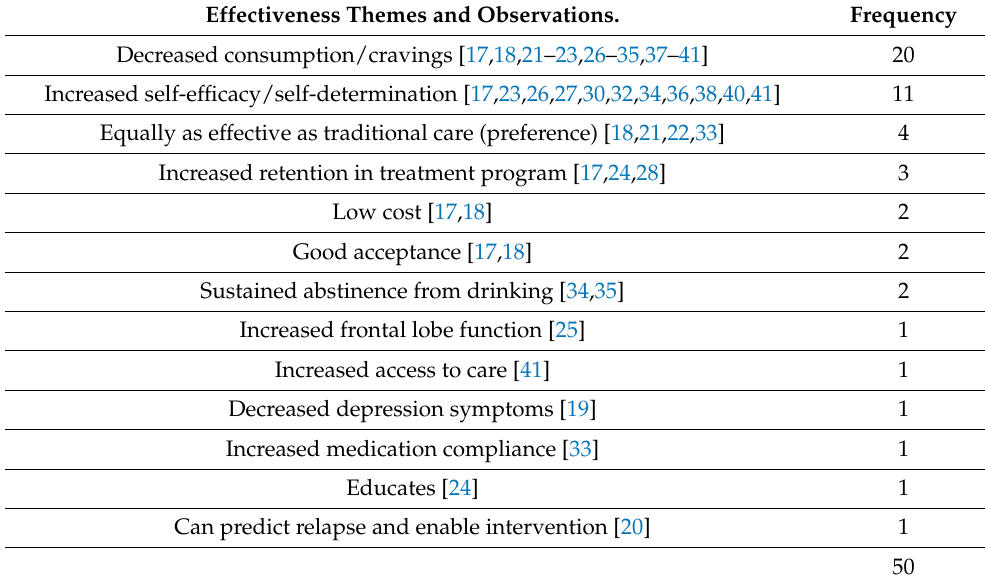
Table 5. Effectiveness Themes and Observations. Effectiveness Themes and